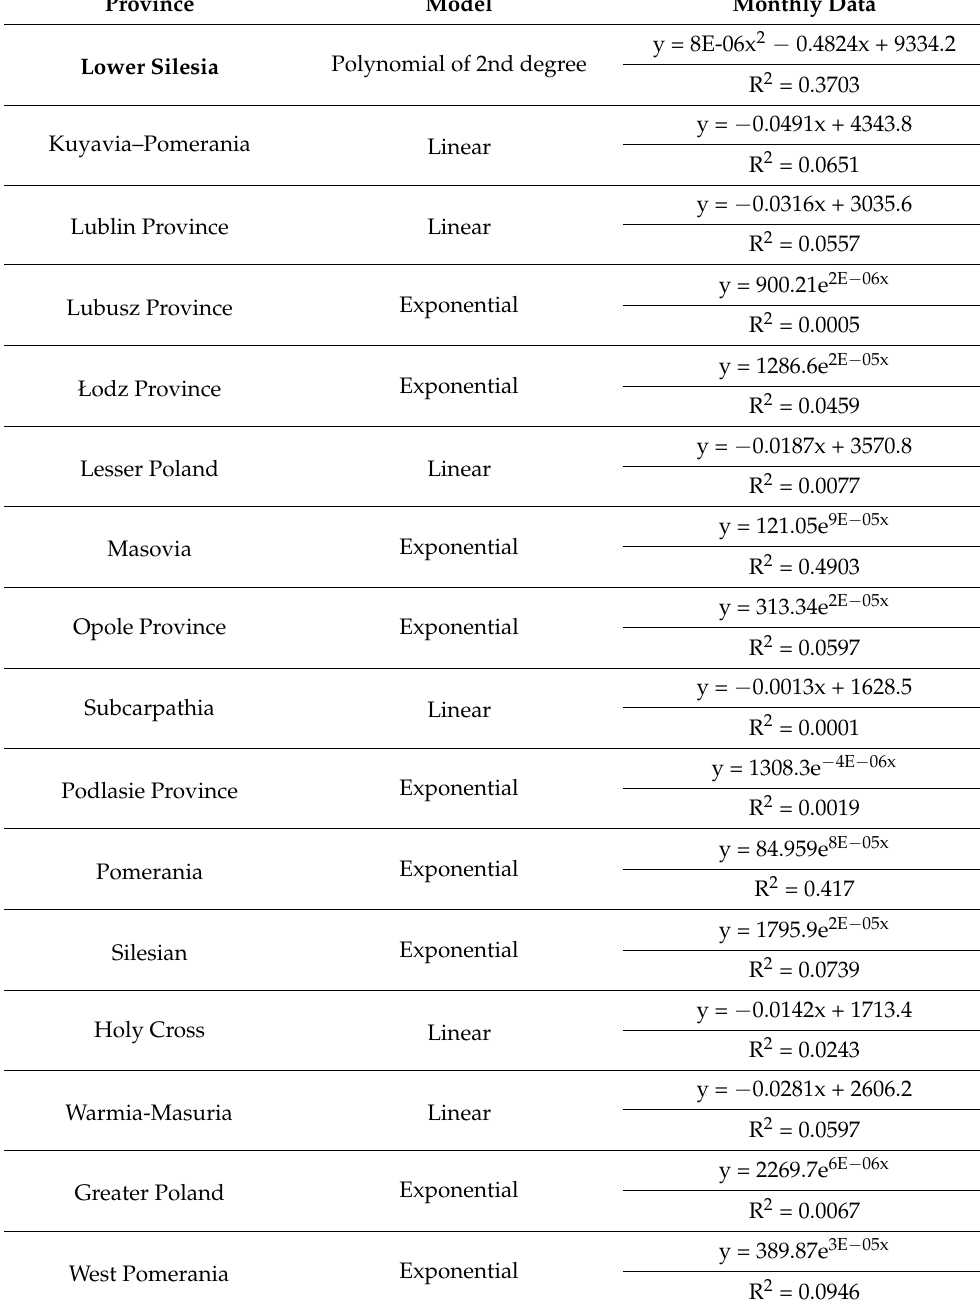
Table 3. Best trend models for monthly